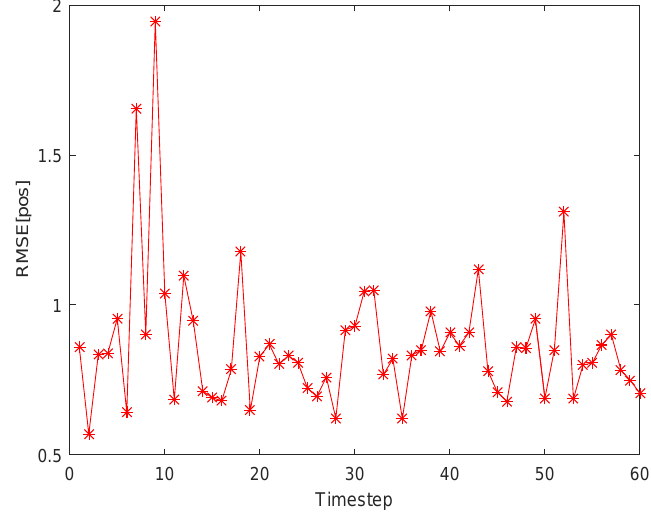
Figure 9. Tracking errors ( RMSE p ) at each timestep using our proposed tracking scheme in a randomly distributed sensor